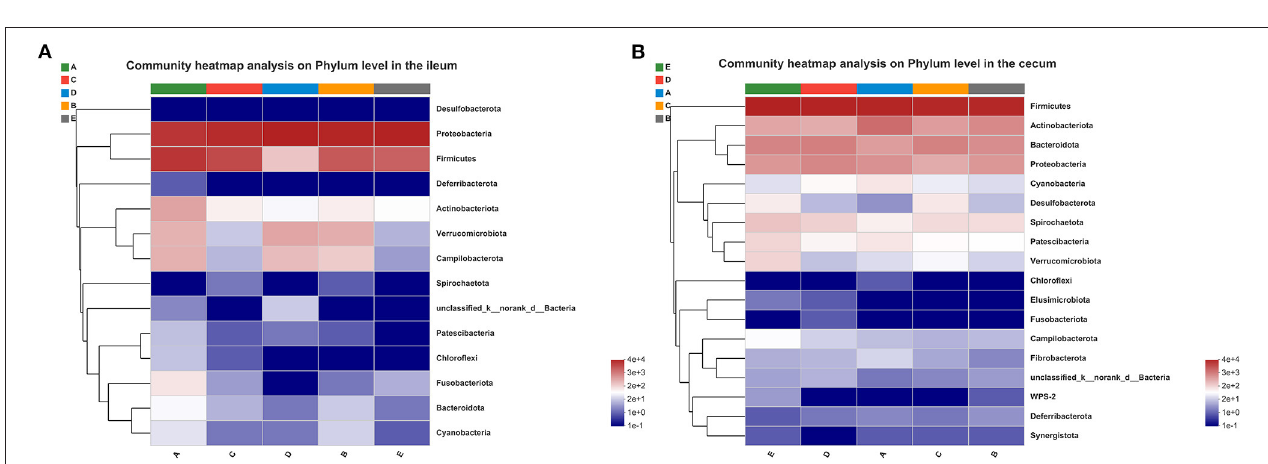
FIGURE 3 | Effects of different diets on intestinal bacterial community structure in weaned piglets. (A) Distribution of ileal bacteria at phylum level in weaned piglets. (B) Distribution of cecal bacteria at phylum level in weaned